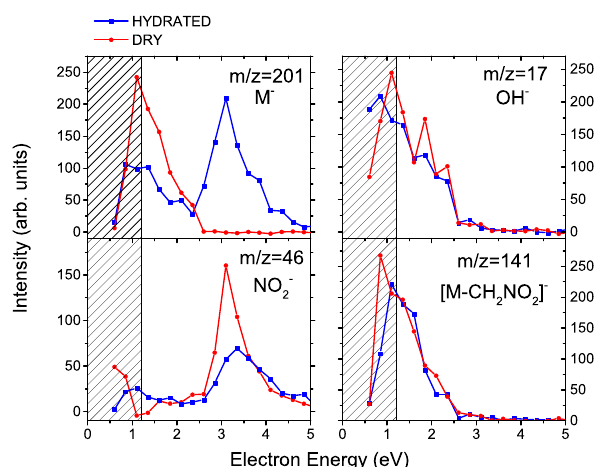
Figure 2. Ion yields for the formation of selected anions from misonidazole as a function of the energy of the incident electron. Red and blue curves show a molecular beam of MISO without and with hydration, respectively (“dry” and “hydrated”). The region of a strong decrease in the electron current is